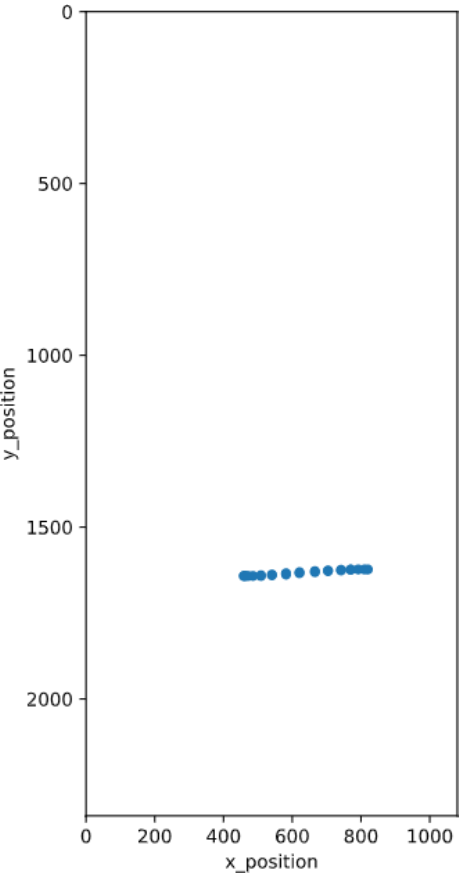
Figure 2. A single gesture visualized at display scale, indicating that more input points are available when starting and finishing the